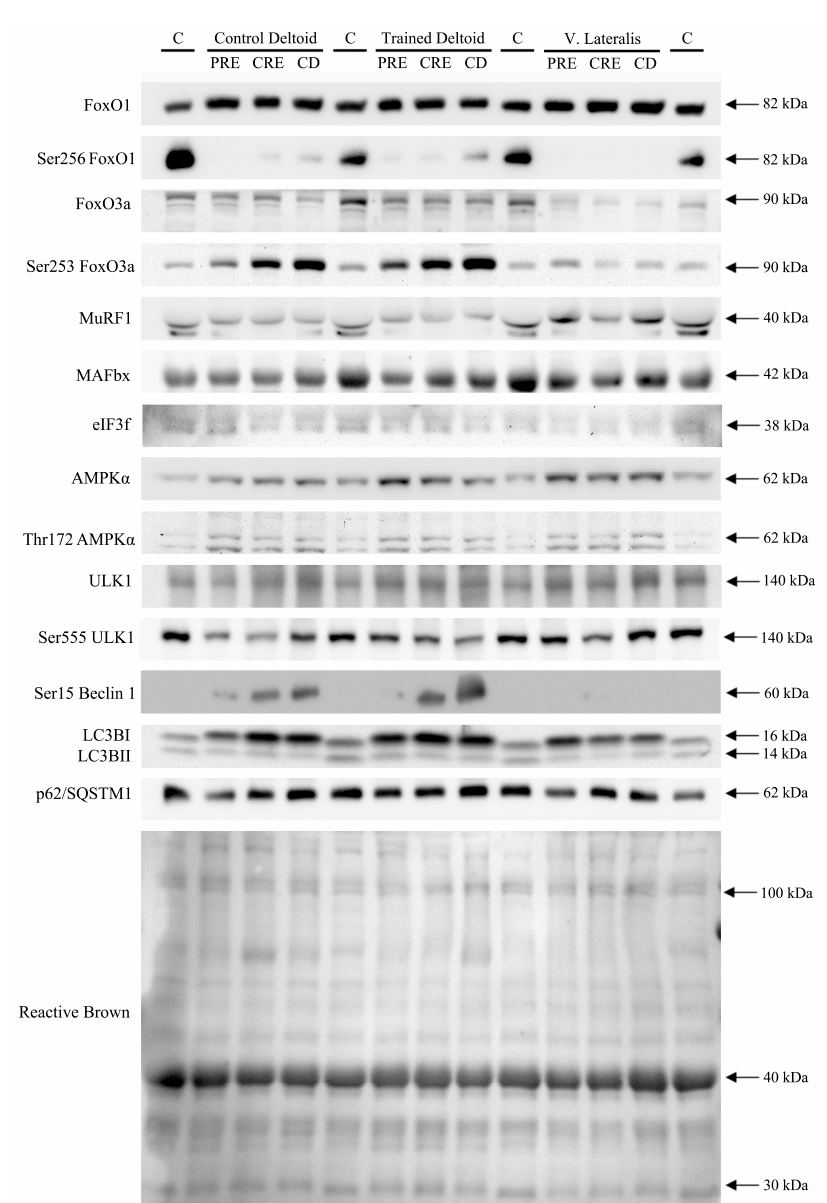
Figure 5. Representative immunoblot images of all proteins studied and their regulatory phosphorylations and the total amount of protein loaded (Reactive Brown staining) from a single participant in the study belonging to the whey protein group. From top to bottom: FoxO1, pSer256 FoxO1, FoxO3, pSer253 FoxO3, MuRF1, MAFbx, eIF3f, AMPK α , pThr172 AMPK α , ULK1, pSer555 ULK1, pSer15 Beclin 1, LC3BI, LC3BII, p62 / SQSTM1 and Reactive Brown (as protein loading control). Quadruplicate assays of a non-intervention human sample were included on each gel as a loading control. The various phases of the intervention are explained in Figure 1. PRE, before the intervention; CRE, caloric restriction and exercise; CD, control diet. Estimated molecular weights are indicated by arrows.